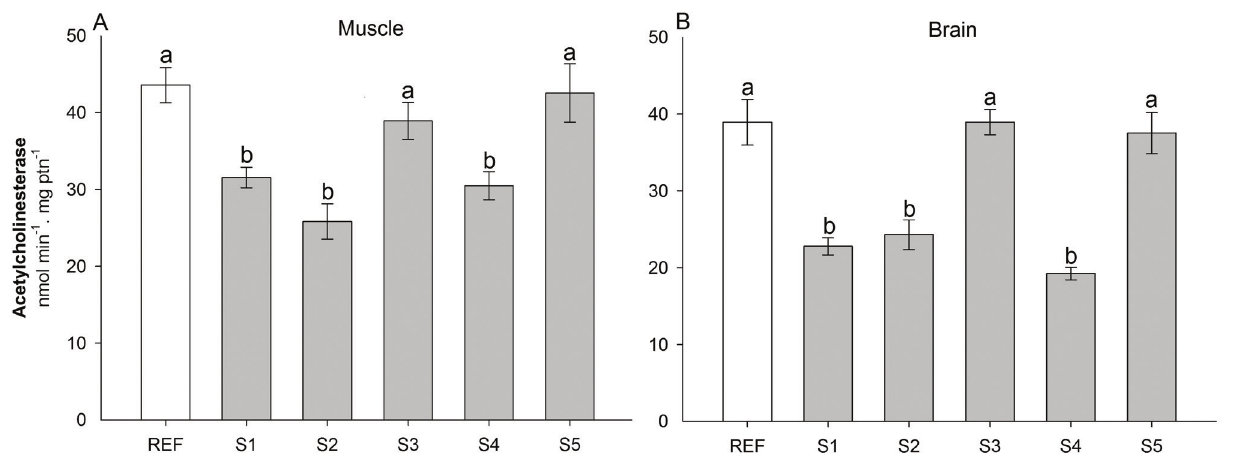
Fig. 5. Activity (mean ± SEM, n = 8) of acetylcholinesterase in muscle (A) and brain (B) of A. altiparanae exposed in situ for seven days in five sites along Água das Araras stream (S1, S2, S3, S4, and S5) and in a reference site (Ref). Different letters indicate significant differences between sites (P <